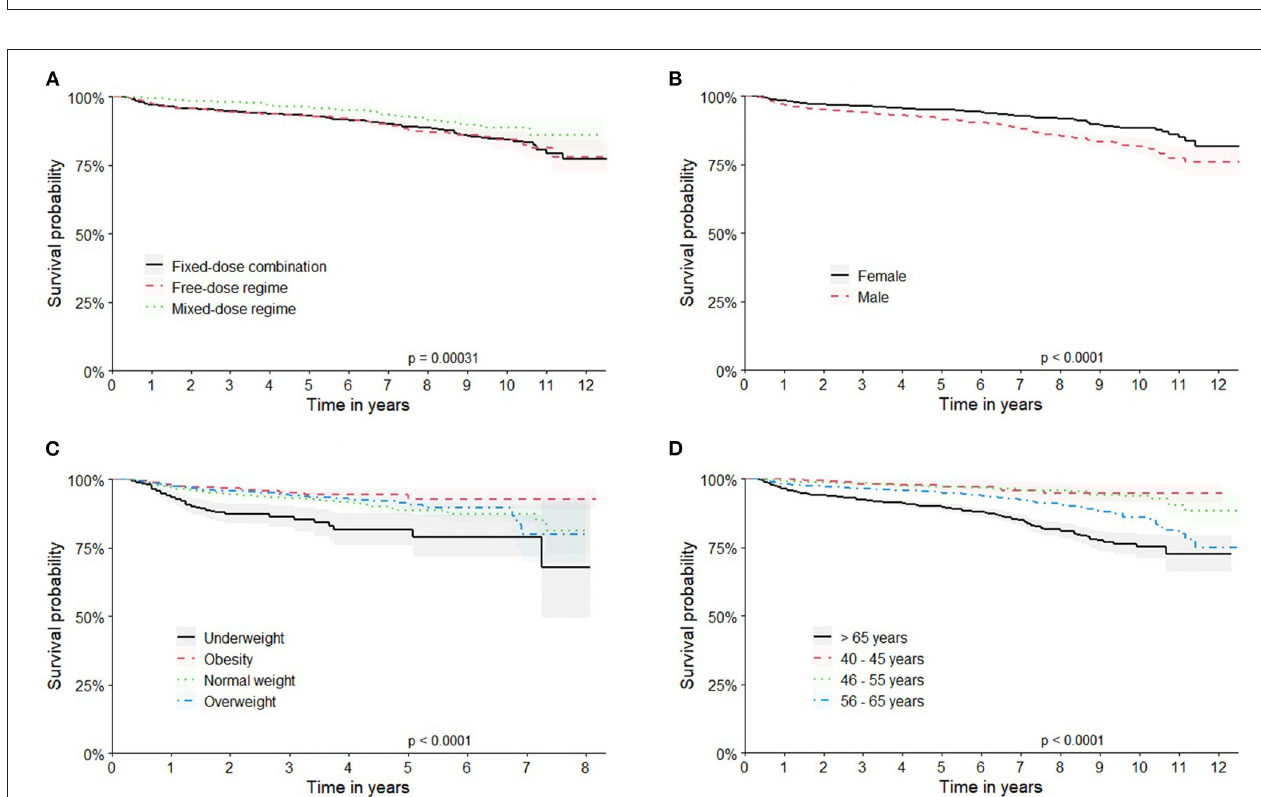
FIGURE 2 | Kaplan-Meier survival curves for COPD patients from 2003 to 2015 included in full and matched cohort.